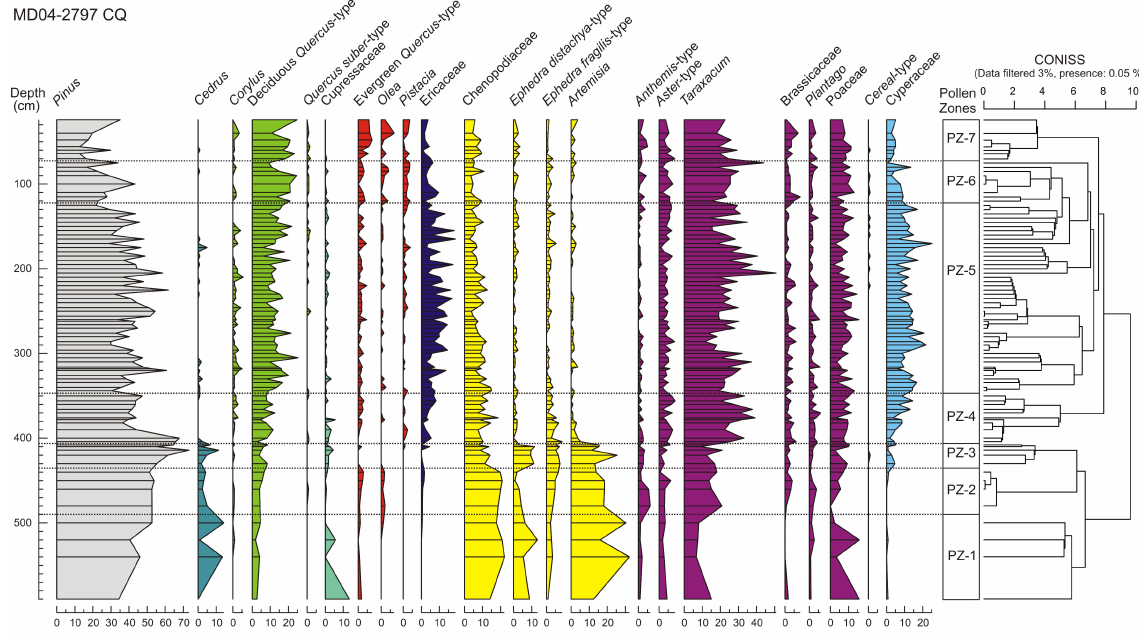
Fig. 3. Percentages of major pollen taxa versus depth, core MD04-2797CQ, Siculo-Tunisian Strait. Boundaries of pollen zones are based on visual inspection of data and application of clustering analysis (see text for